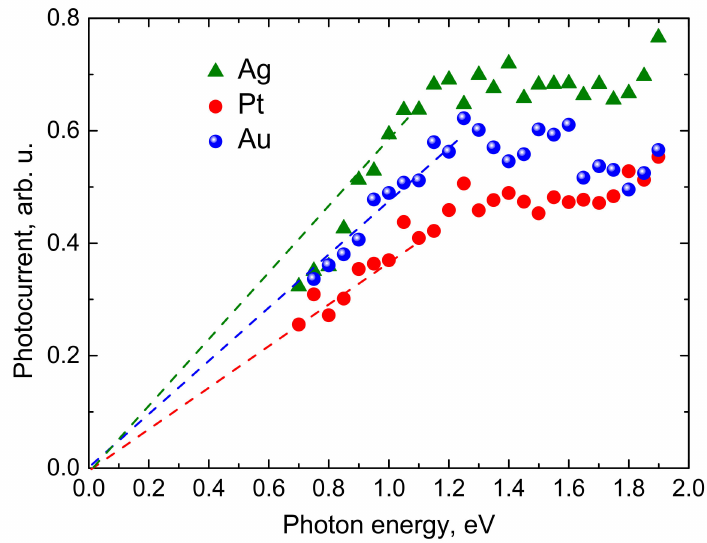
Figure 7. THz photocurrent as a function of the photon energy. Three 100 nm thick bismuth films on different substrates were